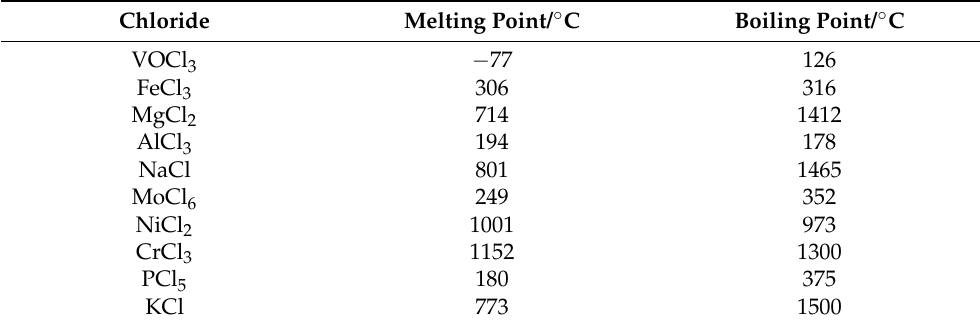
Table 3. Physical and chemical properties of chloride.